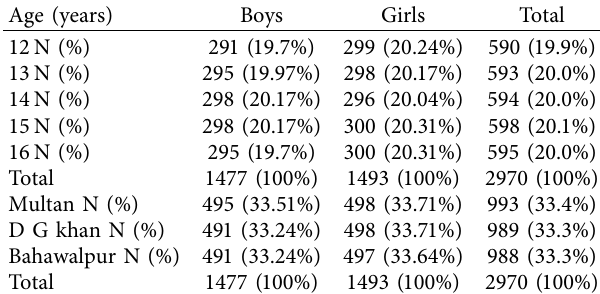
Table 1: Age- and gender-specific demographic